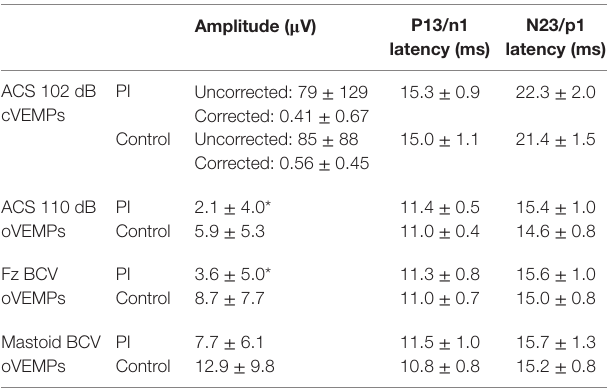
*Non-parametric Mann–Whitney test, p = 0.001.